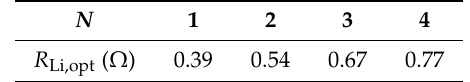
Table 4. Impedances of the loads required for optimal efficiency.